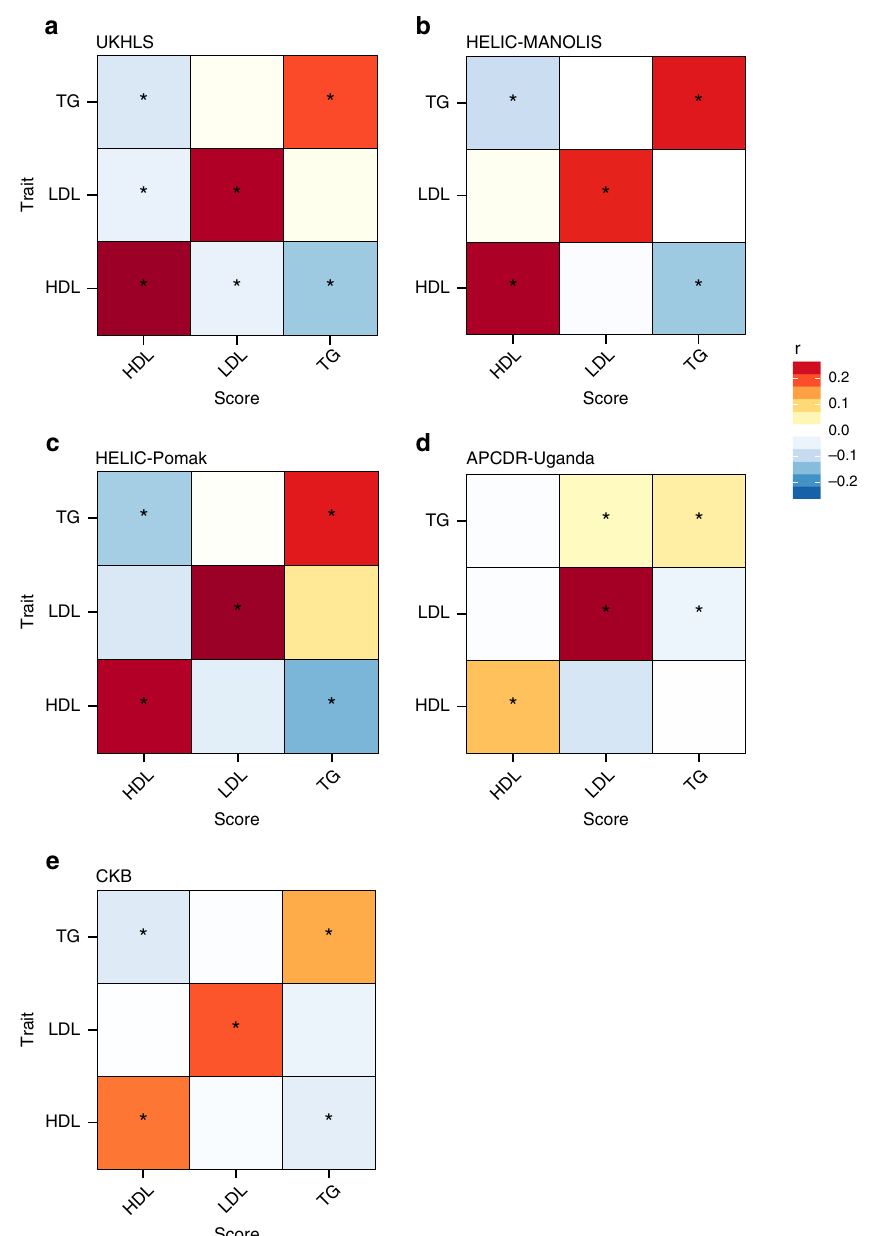
Fig. 2 Associations of genetic risk scores (GRS) based on established lipid-associated loci with serum levels of high-density lipoprotein (HDL), low-density lipoprotein (LDL) cholesterol and triglycerides (TG) in a UKHLS, b HELIC-MANOLIS, c HELIC-Pomak, d APCDR-Uganda, e CKB. Estimates are given as correlation coef fi cients r with colours corresponding to the direction and strength of r. Stars indicate statistically signi fi cant associations based on a score test ( p < 0.0056). The values on the diagonal represent the strength of correlation of a GRS with its target lipid biomarker. The off-diagonal elements show the strength of correlation of a GRS (e.g., TG) with the other lipid markers (e.g.,